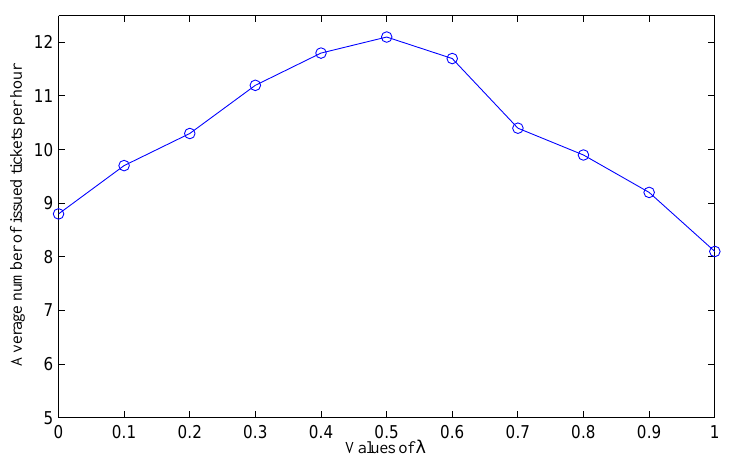
Figure 19. Average ticket issuing productivity of officers under different values of λ and η ( λ + η =